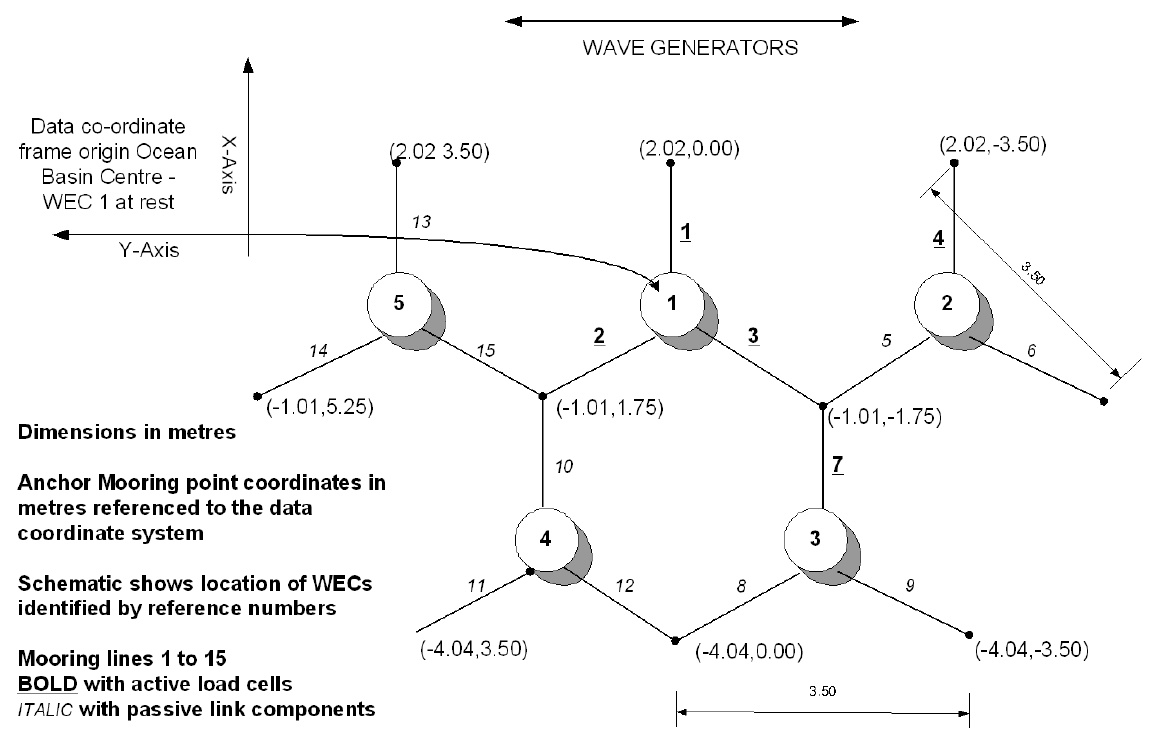
Figure 2. Layout of mooring points showing WEC and mooring line numbers.